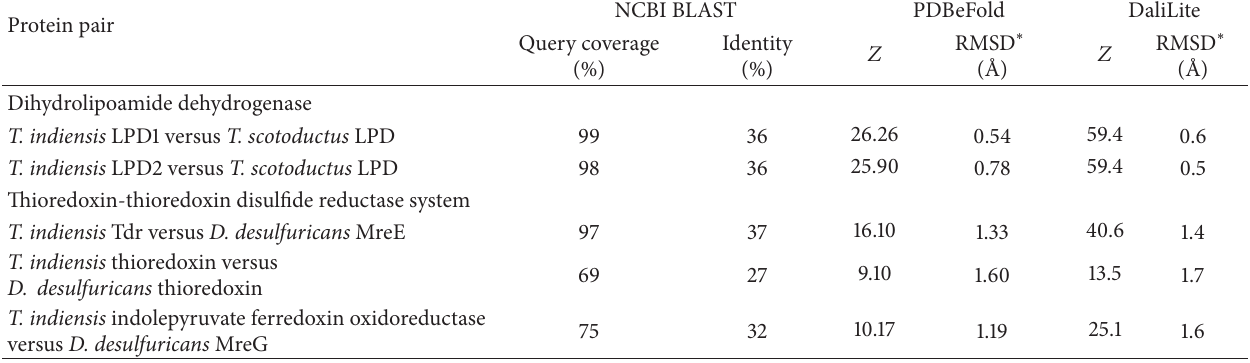
Table 5: Pairwise sequence and structural similarity of T. indiensis proteins with Cr(VI) reductases. Protein